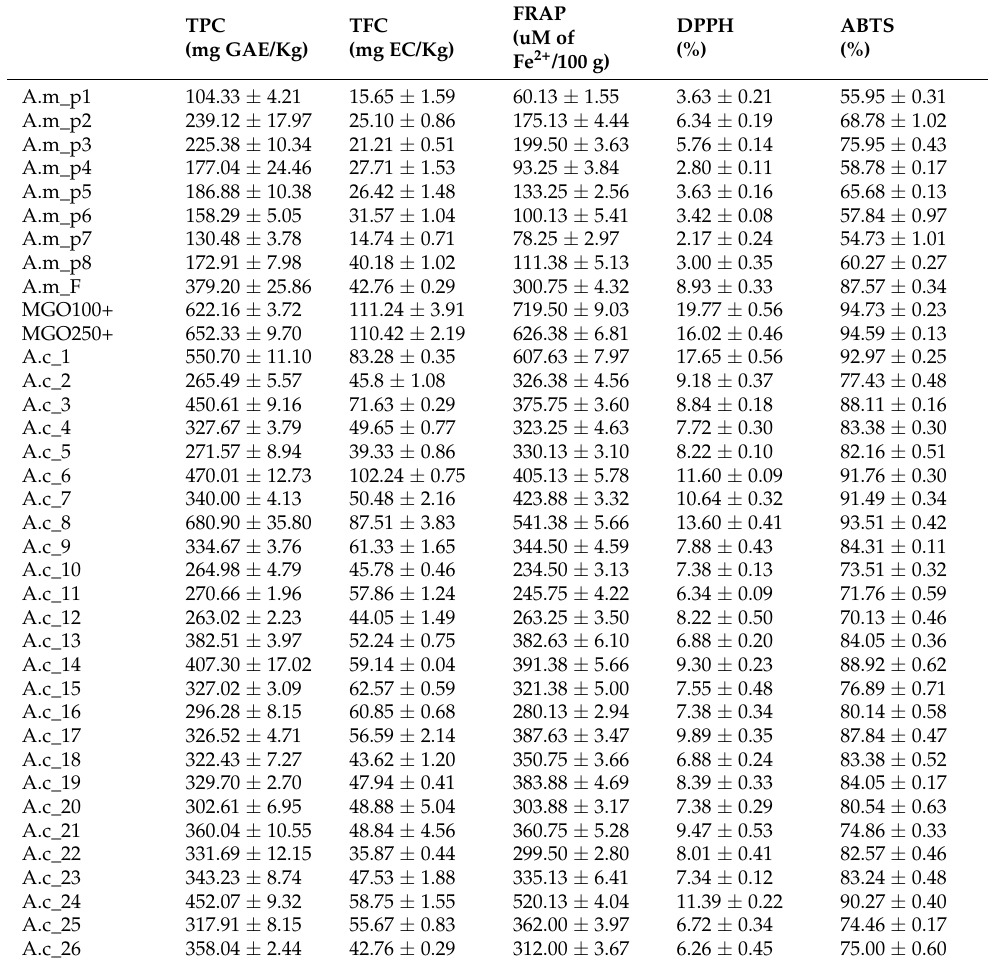
Table 1. Total phenolic and flavonoid contents and antioxidant activity of A. cerana and A. mellif- era